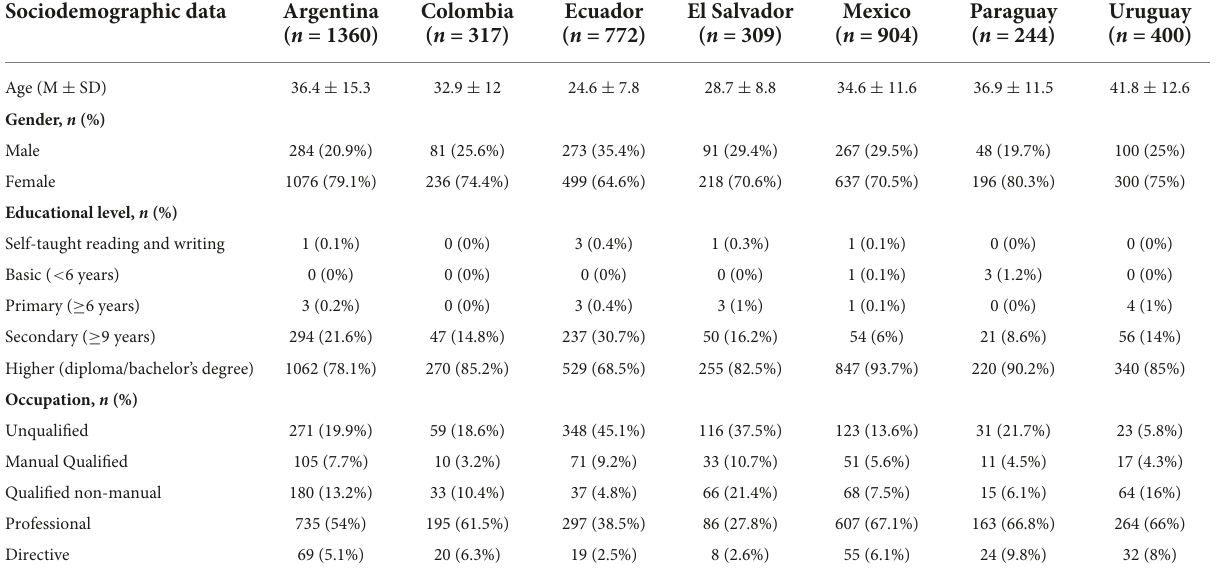
TABLE 1 Sociodemographic characteristics of the participants in the Americas. Sociodemographic